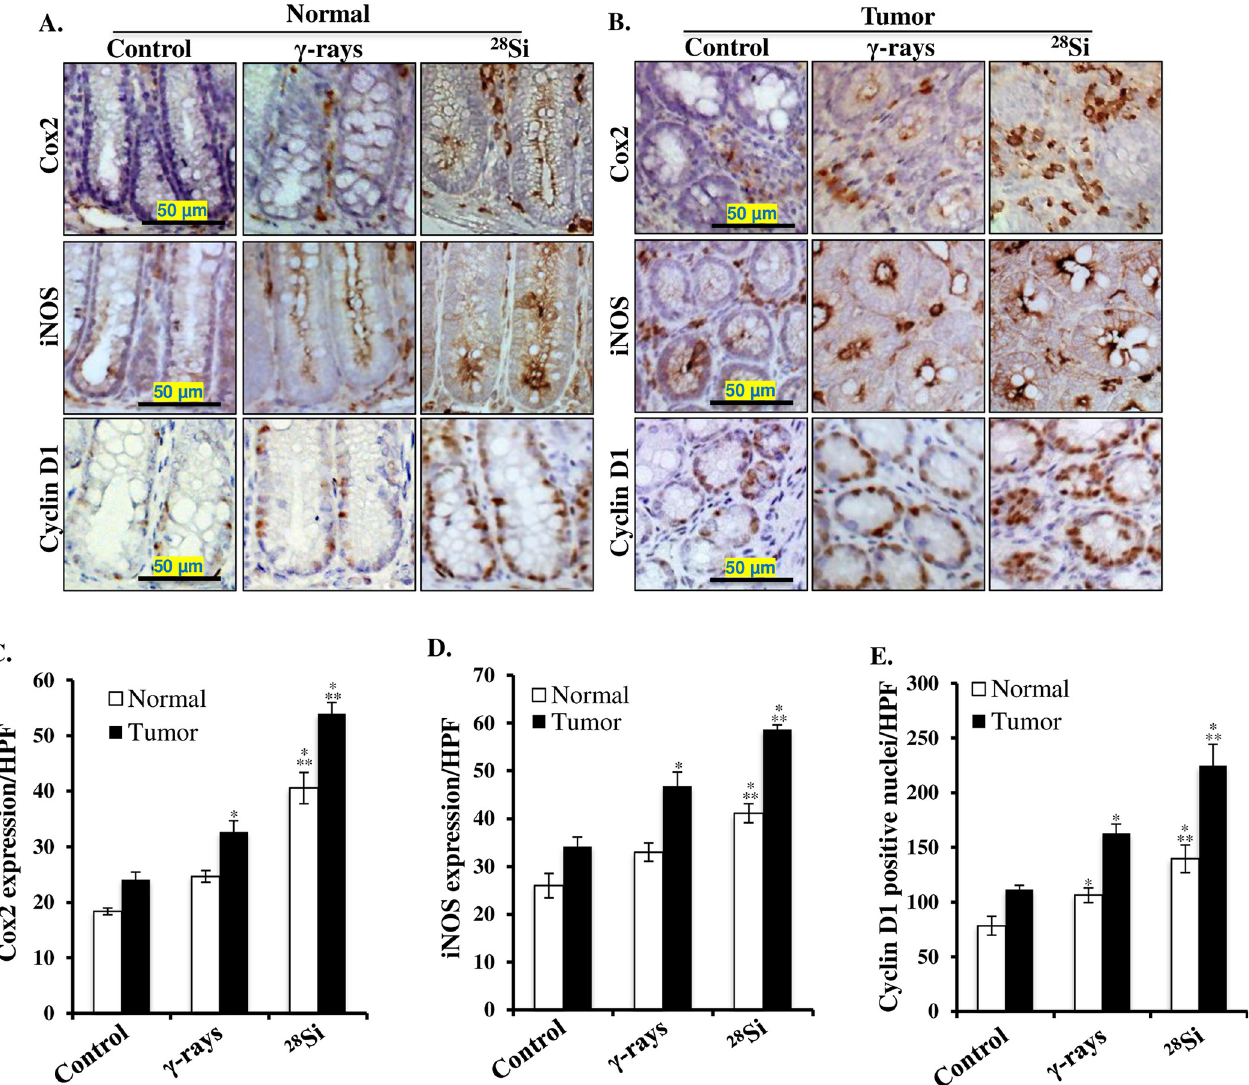
Fig 6. Greater accumulation of common transcription targets of β -catenin and NF- κ B with known pro-inflammatory and pro-proliferative functions in heavy-ion exposed mouse colon. A) Representative images (200X) of COX2, iNOS, and cyclin D1 stained tumor-free (normal) colon sections from control, γ - rays, and 28 Si irradiated mice. B) Representative images (200X) of COX2, iNOS, and cyclin D1 stained colon tumor from control, γ -rays, and 28 Si irradiated mice. C) Quantification of COX2 protein expression measured as DAB intensity per high-powered microscopic field (HPF) in normal and cancer tissues. D) Quantification of iNOS protein expression measured as DAB intensity per HPF in normal and cancer tissues. E) Quantification of cyclin-D1 positive nuclei per HPF in normal and cancer tissues. All bars show mean ± SEM and � indicates a p < 0.05 compared to control and �� indicates p < 0.05 compared to the γ exposed